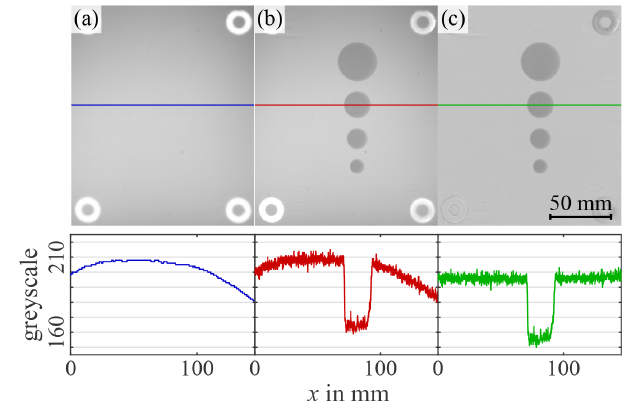
Figure 7. Illumination correction and grey value curve: (a) filtered background image B (cid:48) , (b) in situ image I’, and (c) illumination- Gauss corrected image I”.